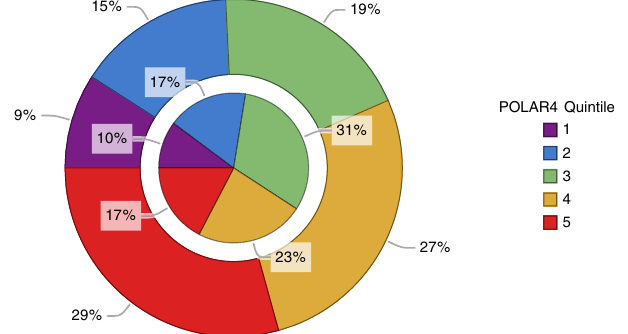
FIG. 1. Percentage of students that attended the Bootcamp in each POLAR4 quintile. The outer ring shows the percentages for the school address POLAR4 quintiles, and the inner ring shows the percentages for the home address POLAR4 quintiles. The total numbers are N ¼ 181 for the schools data and N ¼ 172 for the home